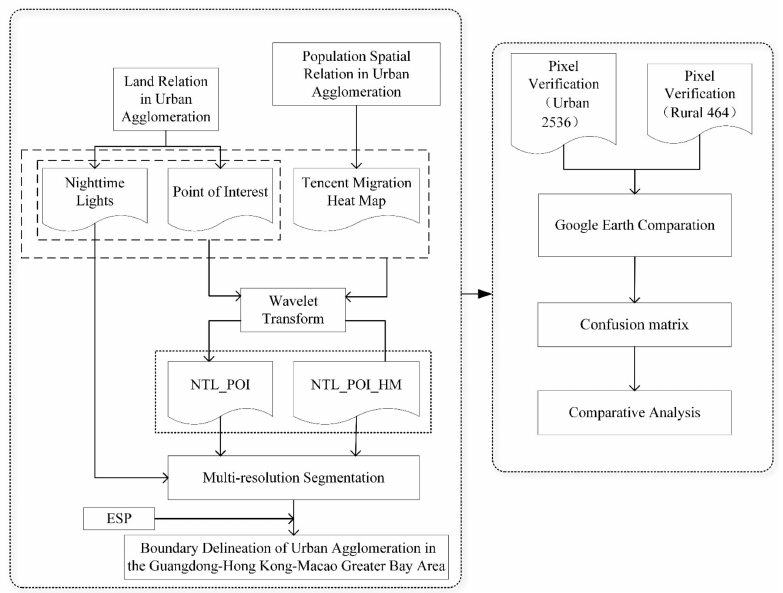
Figure 4. Structure analysis